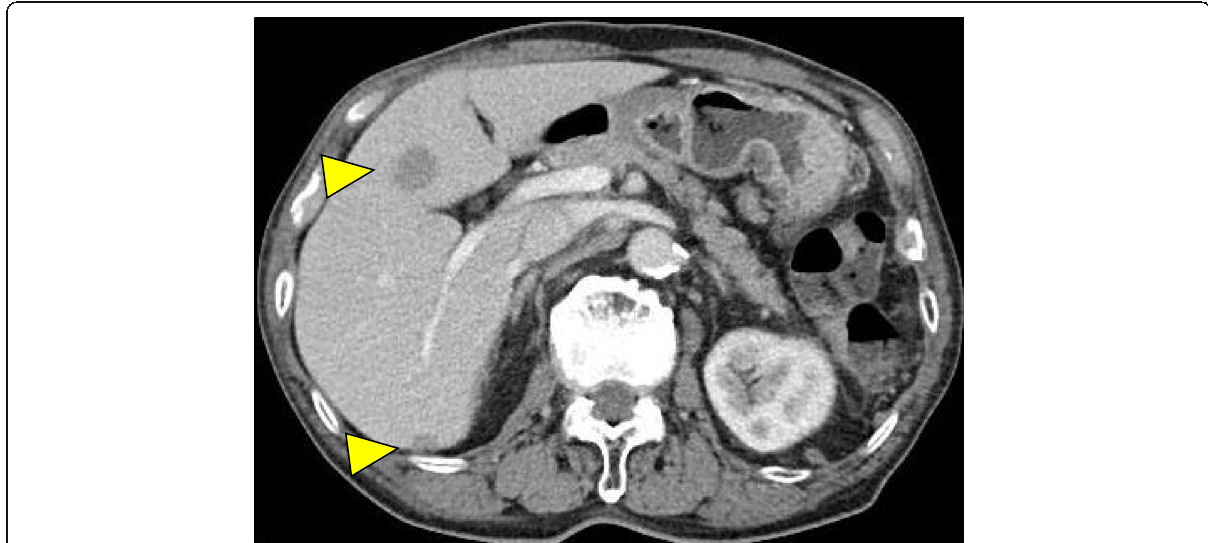
Fig. 7 Abdominal computed tomography scan 6months after surgery revealed multiple metastatic lesions in the liver. A total of 5 lesions were